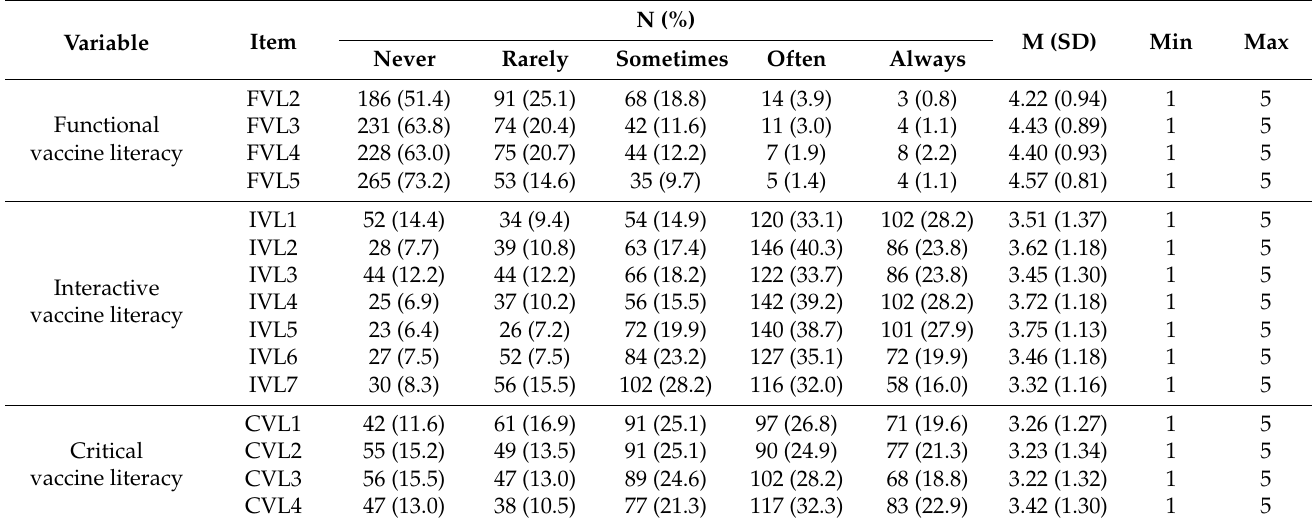
Table 3. Responses to each item of the COVID-19 Vaccine Literacy Scale.